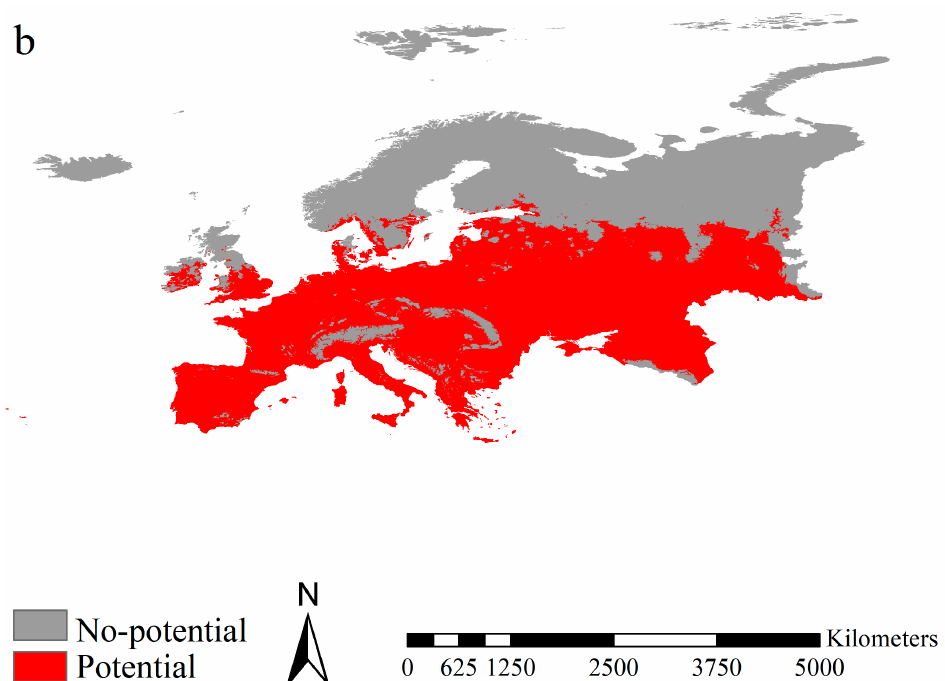
Figure 5. Potential ranges of the fall webworm. ( a , b ) indicate the potential ranges of the fall webworm in Europe and the fall webworm in North America, respectively. The potential ranges for the fall webworm in Europe were mainly projected in France, Austria, Hungary, Croatia, Romania, Bulgaria and Ukraine. The potential ranges for the fall webworm in North America were mostly identified in vast regions of Europe, excluding Norway, Sweden, Finland and North Russia.